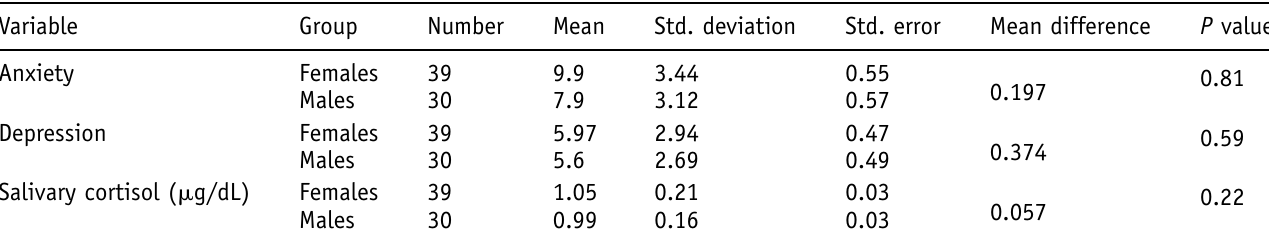
Table IV. Measures of central dispersion for the mean anxiety and depression scores and salivary level of cortisol separately in males and